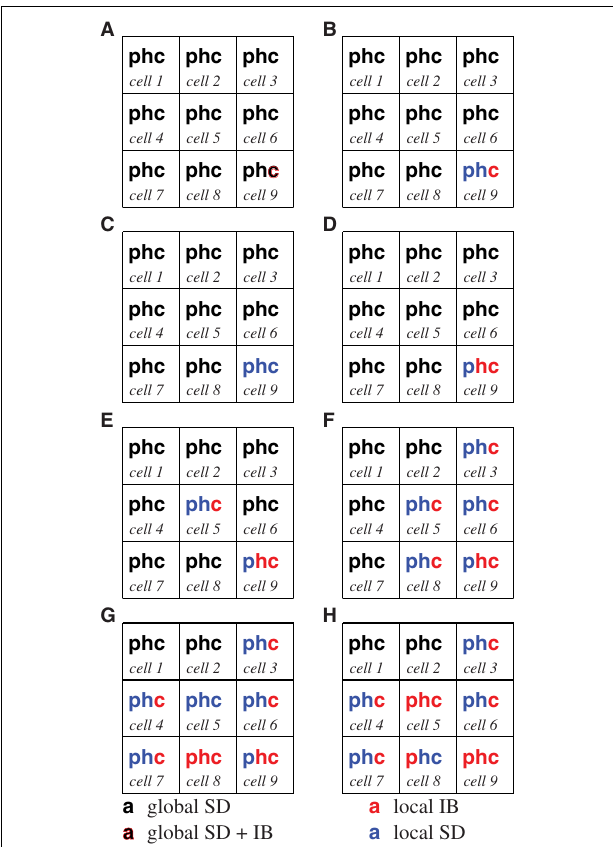
FIGURE 3 | The color of the p,h, and c indicate an agent’s current representation within a cell at various points in the description of a simulation. In each, a black symbol indicates that the biomass of plants (p), herbivores (h), or carnivores (c) is modeled with the global SD agent, a blue symbol indicates that the biomass is modeled with a cell’s SD agent, and red indicates that an IB model is being used. Symbols composed of two colors indicate that more than one representation is currently controlling portions of the relevant biomass. The initial configuration of the model is represented in